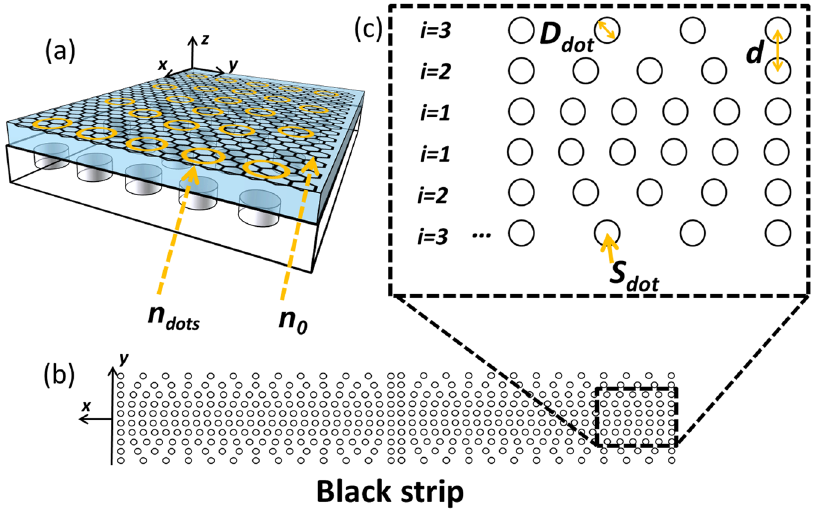
Figure 4. ( a ) Illustration of index n dot and n 0 for dots region and background region, respectively. ( b ) Top-view of the black strip on graphene metasurface. ( c ) The schematic of dot distribution for the black